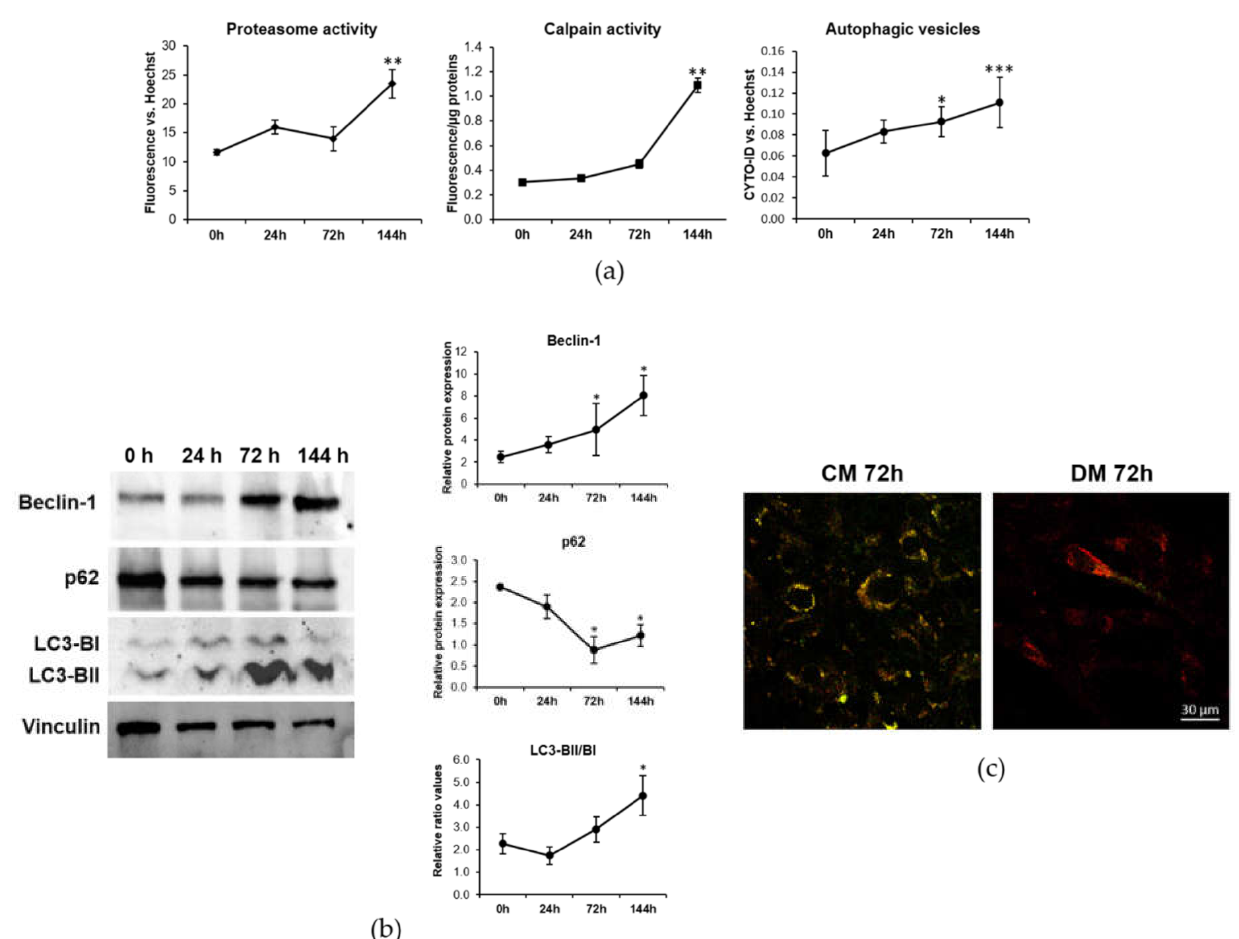
Figure 3. Calpains, proteasome and autophagy are activated during myogenesis. C2C12 were induced to differentiate in DM. ( a ) Proteasome and Calpain activity and autophagic vesicles were measured as described in the methods. ( b ) The amounts of Beclin-1, p62 and LC3-BII/LC3-BI were analyzed by western blot. Vinculin was used as control of loading. A representative blot (left panel) and densitometry performed on three independent experiments and obtained by ImageLab (right panel) are shown. ( c ) Autophagic flux imaging was performed by the Tandem fluorescent-tagged LC3 assay as described in the methods. Non-parametric Mann–Whitney test was performed to define statistical significance among the time points. * Indicates significance compared to 0 h. * p ≤ 0.05; ** p ≤ 0.01; *** p ≤